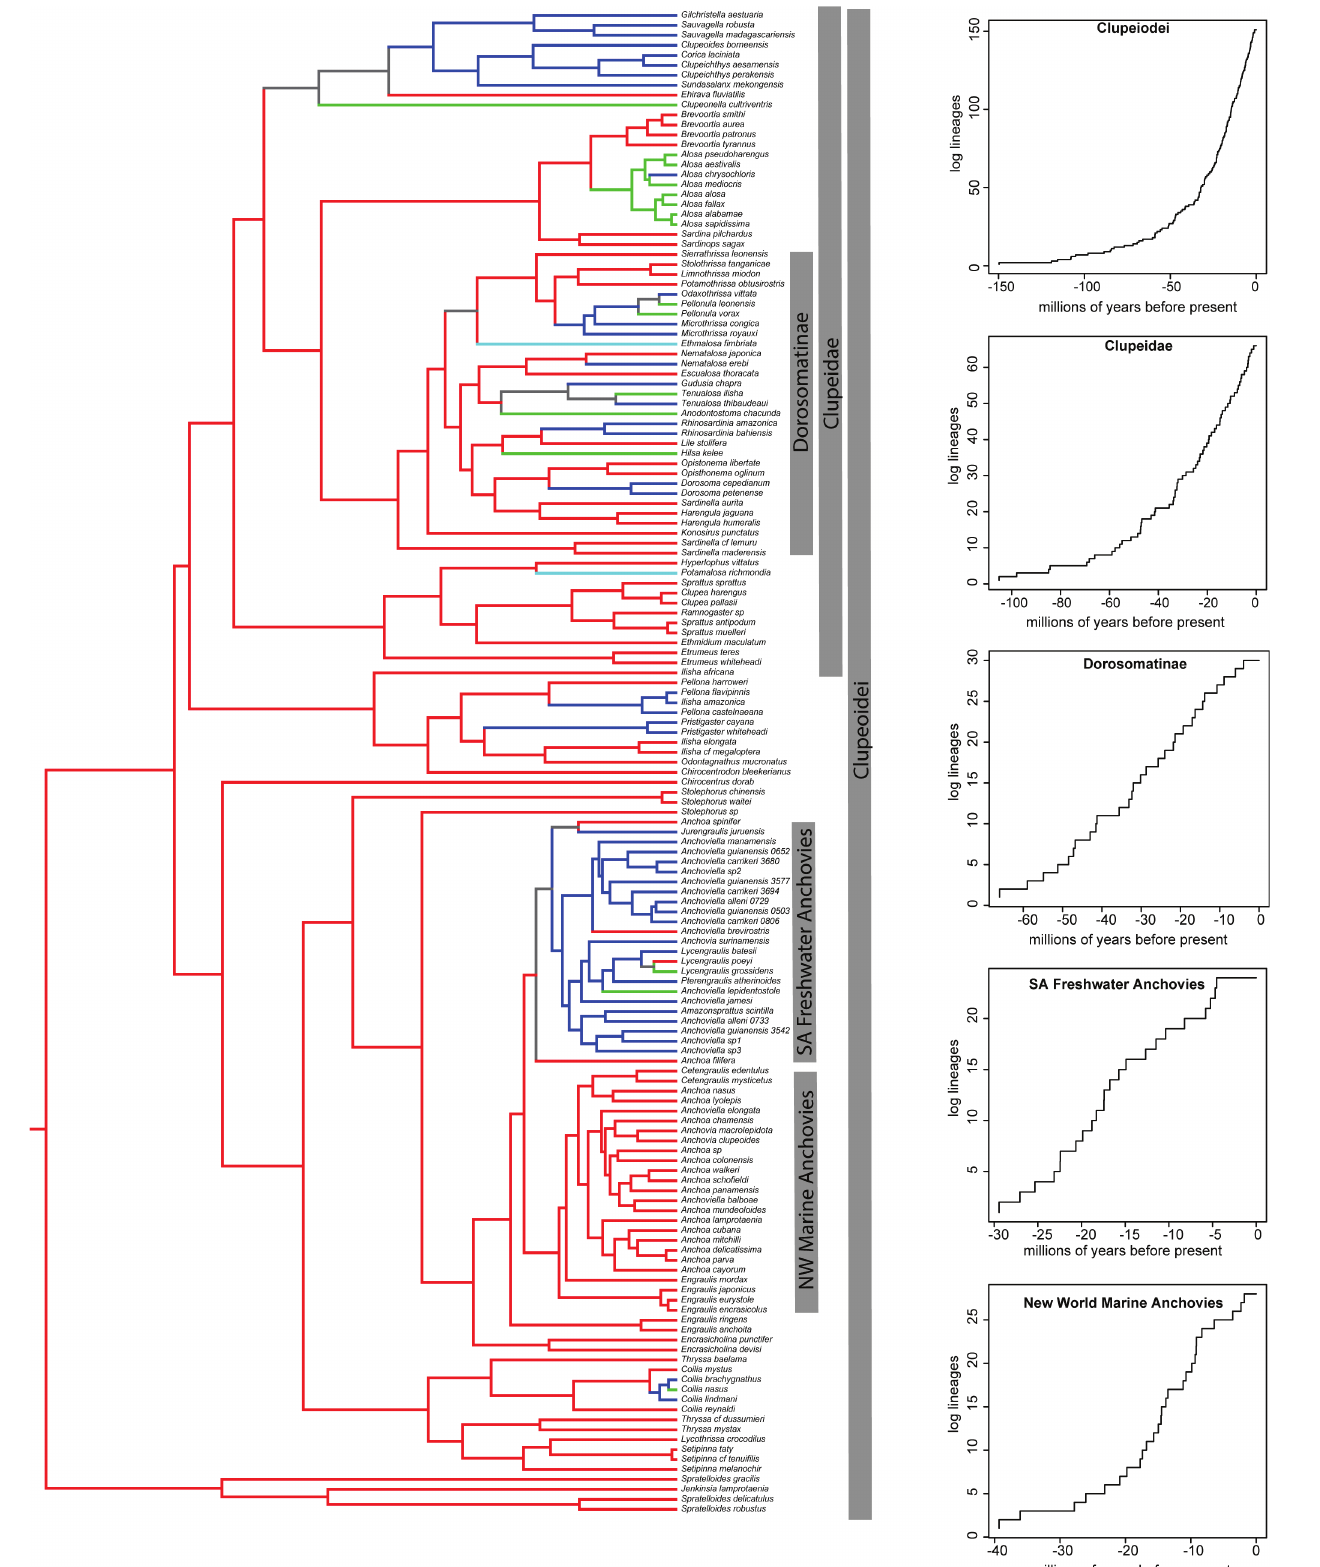
Fig. 5. The left panel shows a phylogeny of Clupeiformes showing ancestral reconstructions of marine (red), freshwater (blue), anadromous (green) and catadromous (light blue) lineages from Bloom, Lovejoy (2014). The right panel shows line- age through time plots for select clades, which are indicated by grey